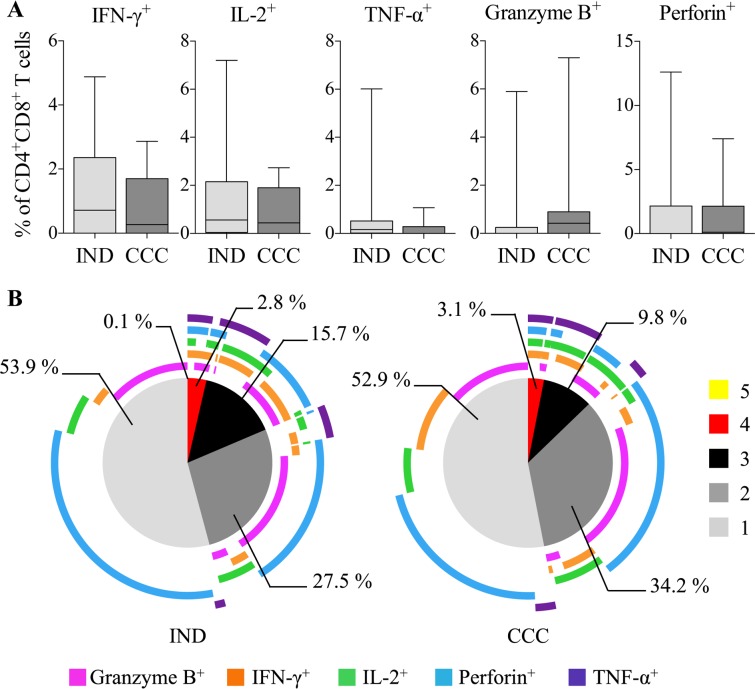
Functional and multifunctional capacity of T. cruzi-specific CD4+CD8+ T cells in IND and CCC.(A) Frequency of CD4+CD8+ T cells producing IFN-γ, IL-2, TNF-α, perforin or granzyme B against TcSA, in IND and CCC. (B) Multifunctional activity profiles of T. cruzi-specific CD4+CD8+ T cells in IND and CCC. The color of the portions of the pie charts depicts the number of molecules produced by CD4+CD8+ T cells in response to T. cruzi antigens. The arcs of the pie charts represent the proportion of cells expressing each one of the molecules under study. The cChD were divided into IND (n = 13) and CCC (n = 15).